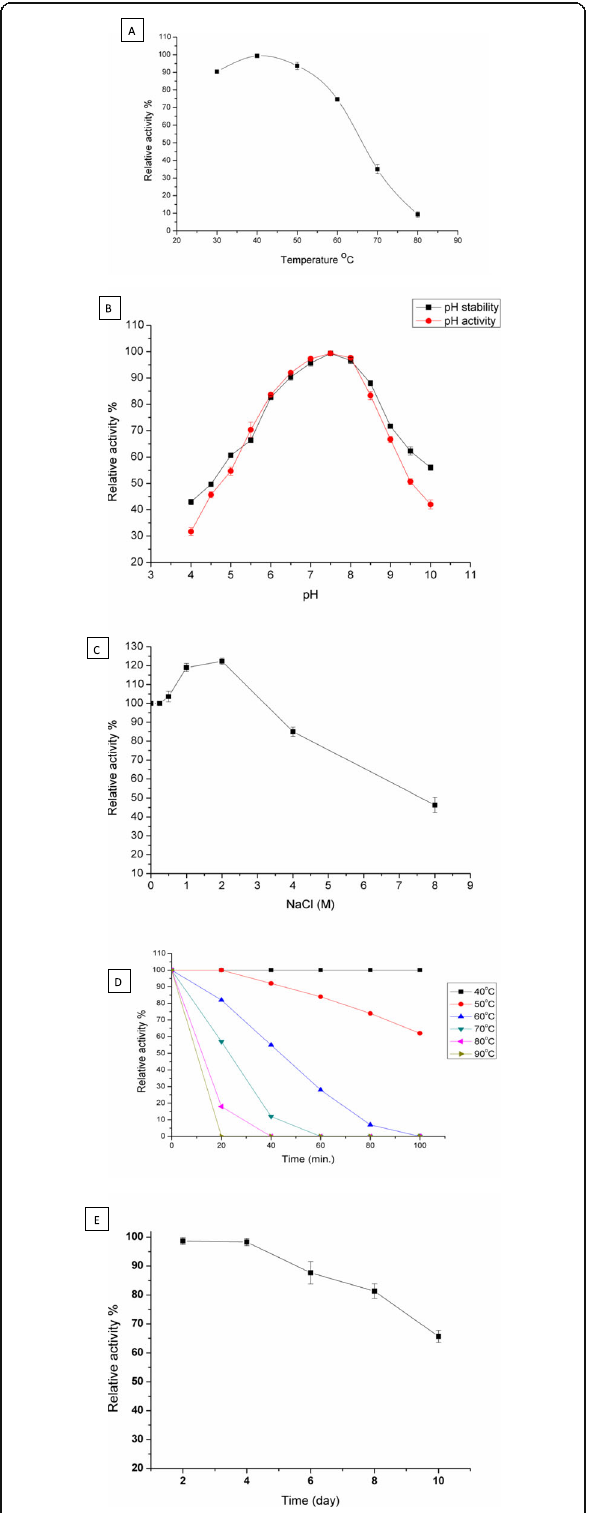
Fig. 3 Biochemical characterizations of the trans-mutant E. coli DH5 α LacZ. a Effect of temperatures (30 – 80 °C) on the enzyme activity carried out at pH 6.5 and 5 mM of o NPG. b Effect of pH on the enzyme activity and stability using different buffers (pH 4 – 10) at 40 °C and 5 mM of o NPG. c Effect of the ionic strength on the enzyme activity using NaCl (0.25 – 8 M) at 40 °C, pH 7.5 and 5 mM o NPG. d Thermal stability of the enzyme carried out at different temperatures (40 – 90 °C). e Enzyme stability at 4 °C, pH 7.5 and 5 mM o